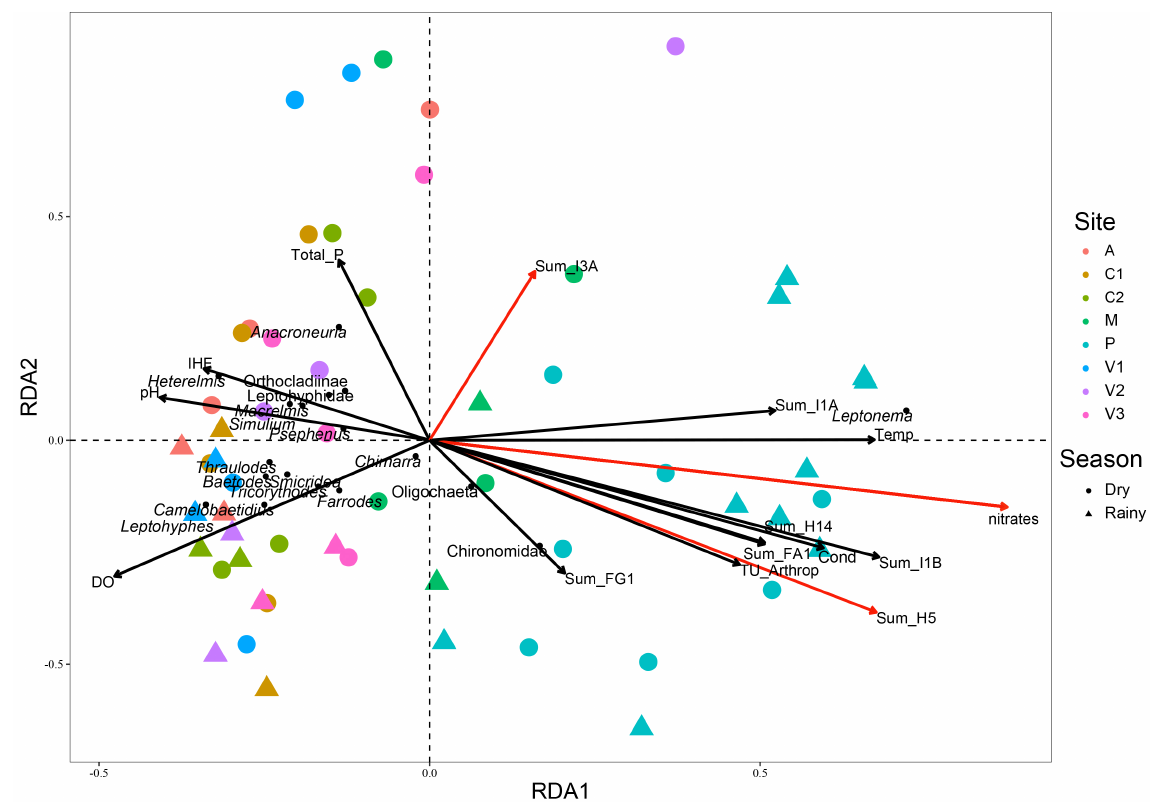
Figure 3. RDA biplot showing the relationships between environmental and macroinvertebrate community data in the Volc á n River watershed. The ordination of sites with respect to the explanatory variables and selected taxa are shown. Labels: A = Angel, C = Cañas, M = Maura, P = Peje, and V = Volc á n. Marked in red are the most relevant explanatory